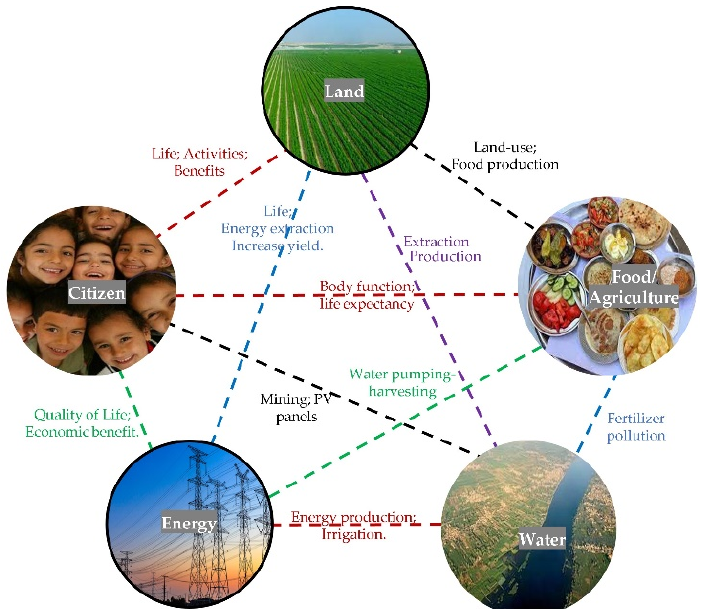
Figure 1. Some keys to the high interlocking relations between natural resources nexus and humans. Enhancing one element supports the others. The study focuses on land use and energy.